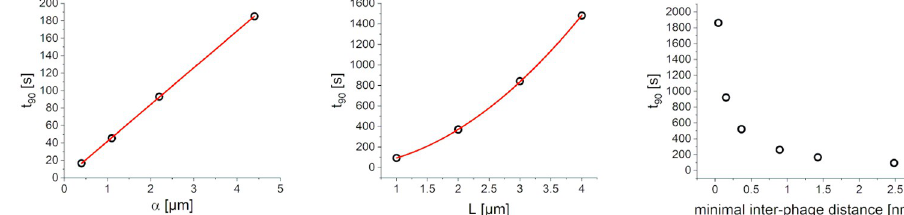
Fig 5. Dependence of equilibration time on model parameters. The dependence is shown for the binding equilibrium constant α , with a linear fit indicated by the red line, the tactoid width L , with the red line showing a quadratic fit, and the phage packing density, quantified as the minimal inter-phage distance.